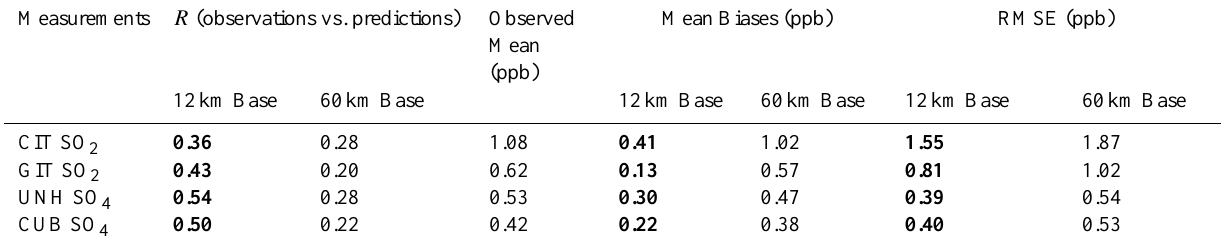
Measurements R (observations vs. predictions) Observed